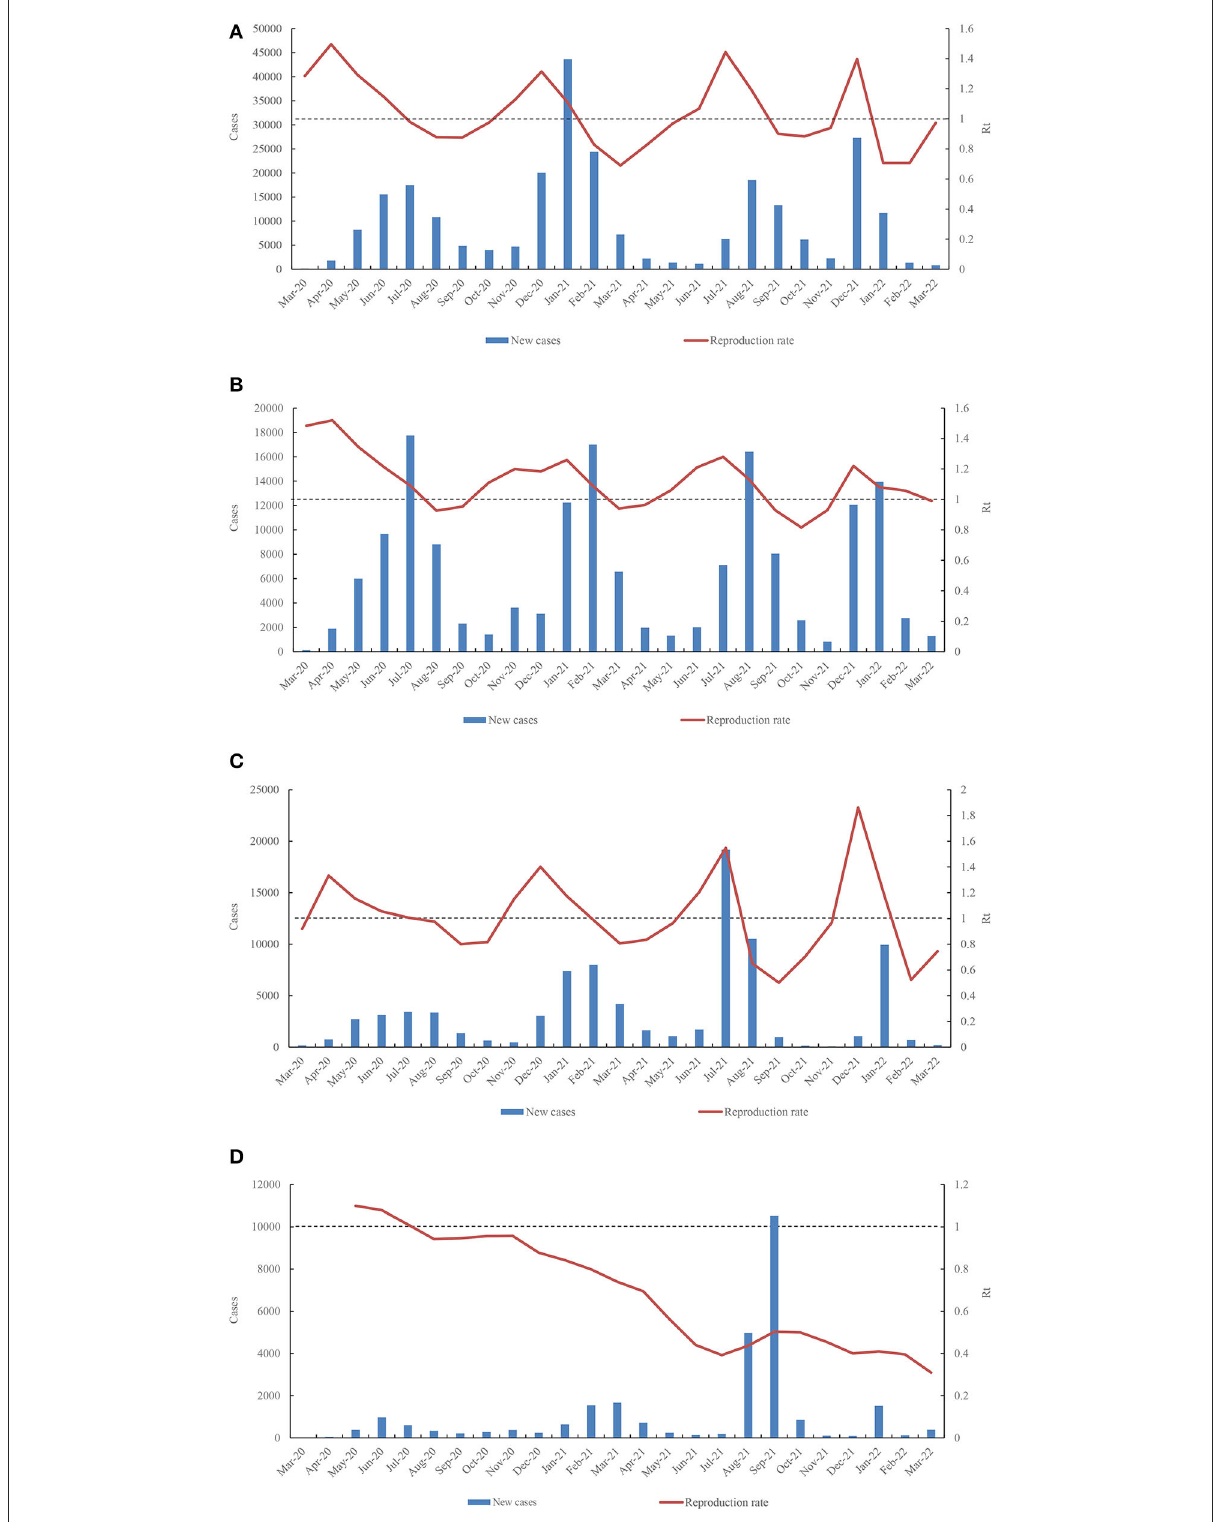
FIGURE6 Dynamic fluctuation of Rt value in four countries (A) (NGA), (B) (GHA), (C) (SEN), and (D) (BEN) among the four waves COVID-19